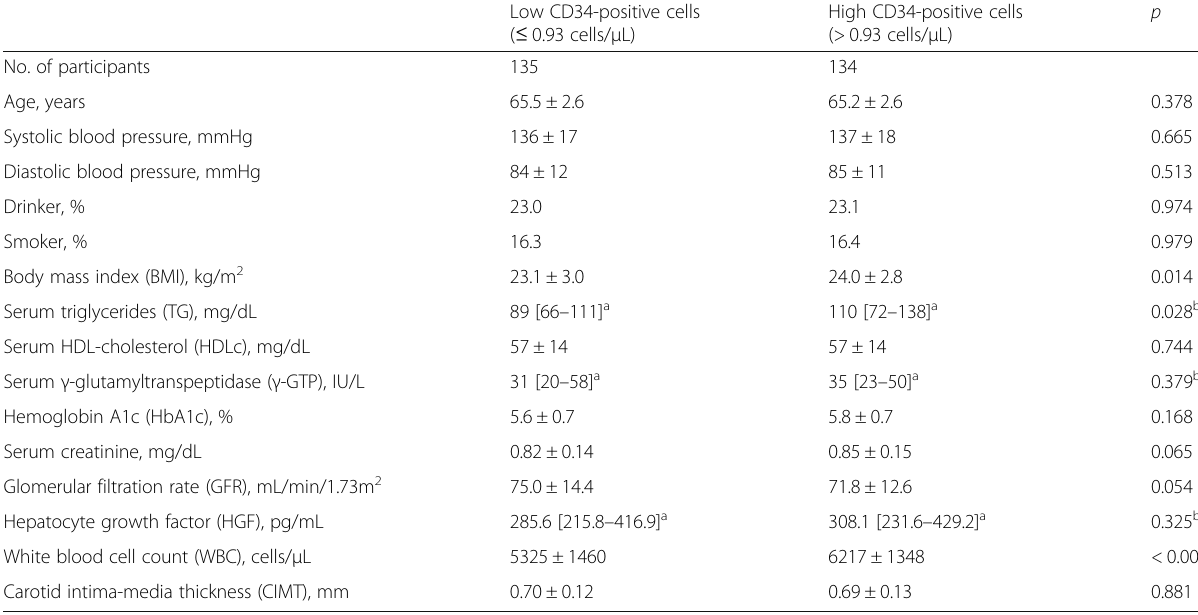
Table 1 Characteristics of the study population based on CD34-positive cell